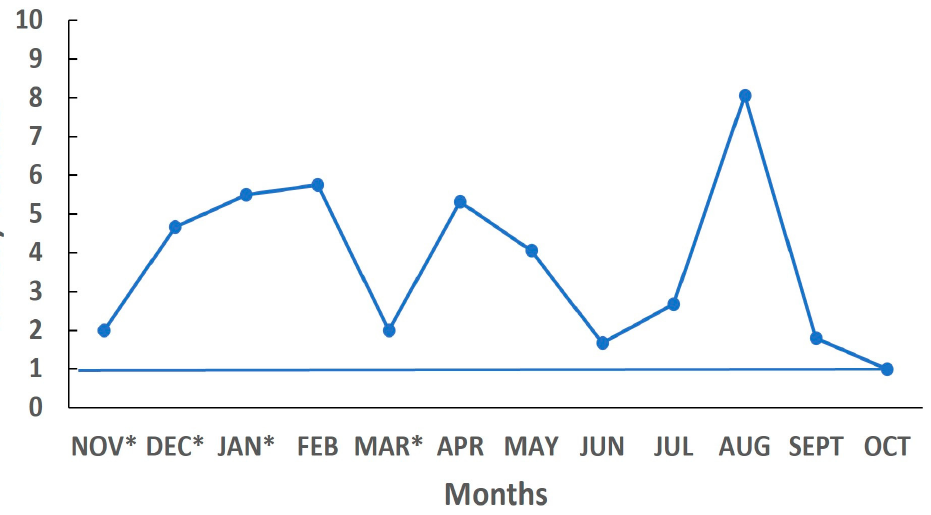
Figure 4. Sex ratio of the blue crab Callinectes sapidus in the period November 2020–October 2021 in Monolimni Lagoon and the adjacent coastal area. * Sex ratio was not tested (number of specimens collected <50 crabs).